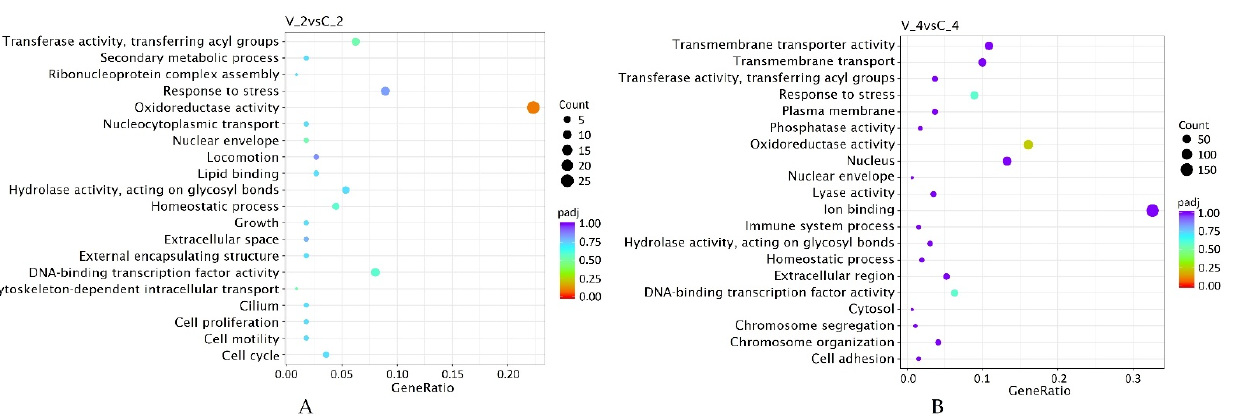
(Table S2). Statistically significantly upregulated DEGs (gene ratio 19:65) at 2 dpi were identified in the molecular function oxidoreductase activity (Figure 5A). Meanwhile, at 4 dpi, the oxidoreductase activity function genes were downregulated at a ratio of 54:256, and the biological process response to stress was upregulated at a gene ratio of 26:204 (Figure 5B).